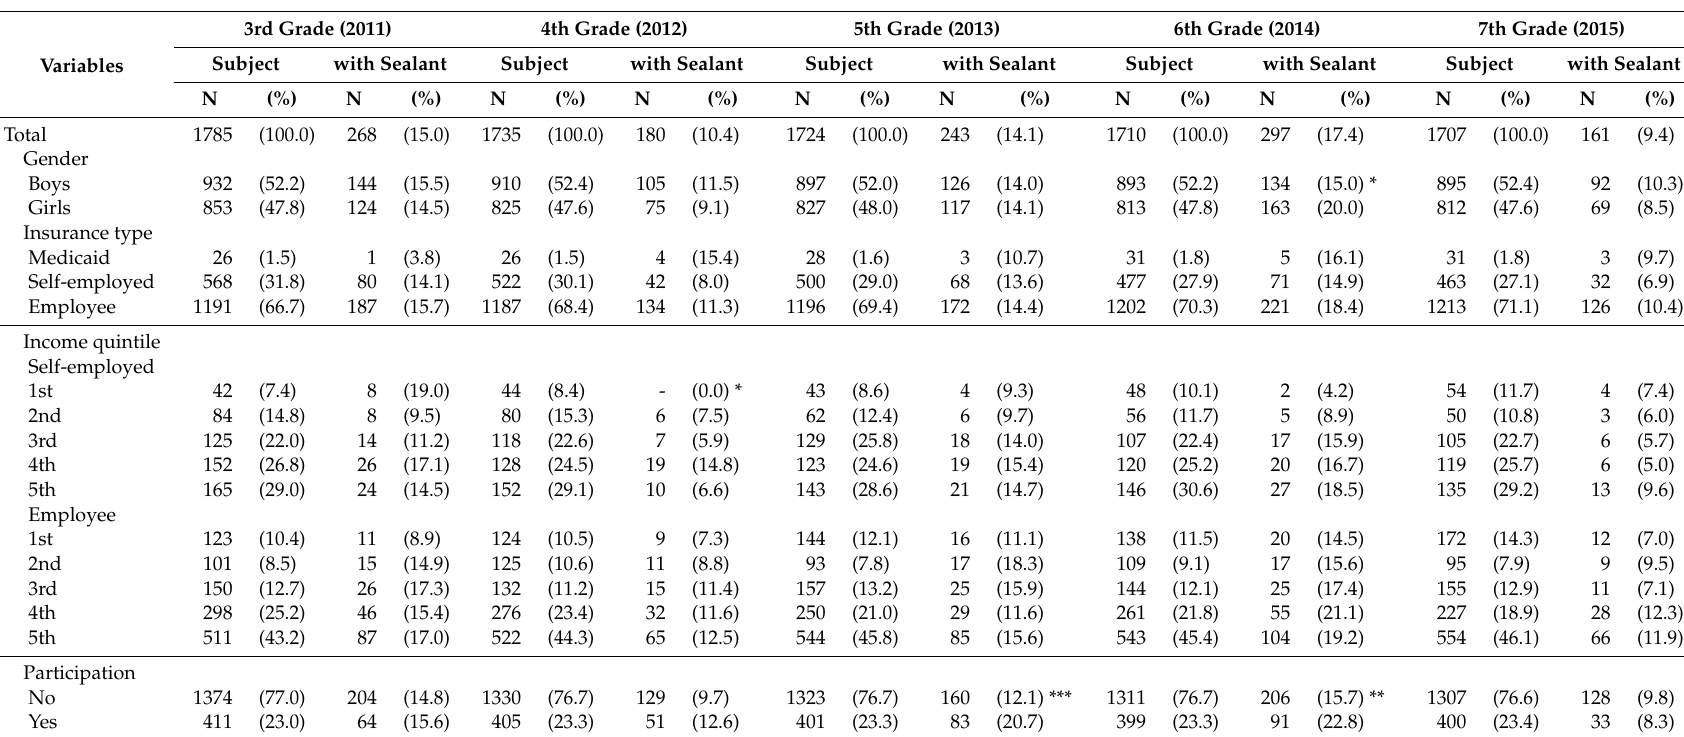
Table 1. The distribution of study sample cohort with dental sealant in the National Health Insurance Sharing Service (NHISS).